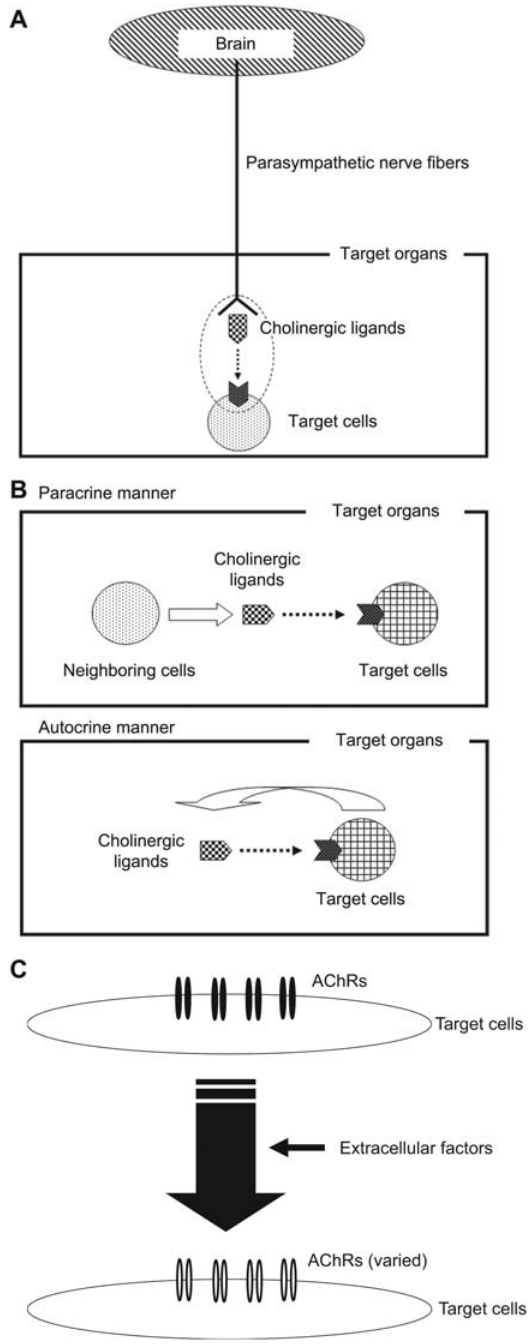
Figure 1 Cholinergic receptor regulation via a neuronal or non- neuronal manner and receptor modulation by extracellular factors. (A) Target cells are dominated by central nerves. (B) Target cells are dominated by neighboring cells or themselves. (C) Extracellular factors alter the repertoire of cholinergic receptors. Ellipses repre- sent AChRs; white ellipses represent altered AChRs.